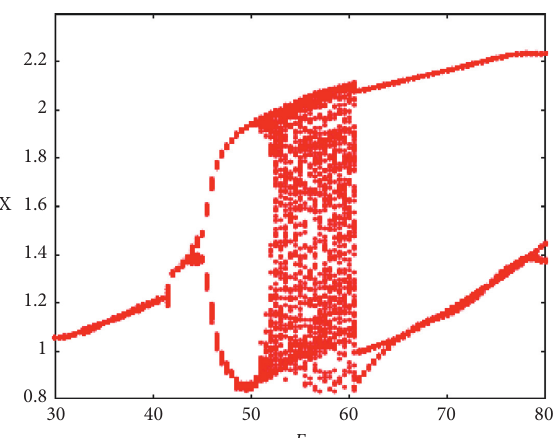
Figure 7: Local bifurcation diagram of the system at τ � 1.2 and ω � 3.5 ( c � 0.5, c